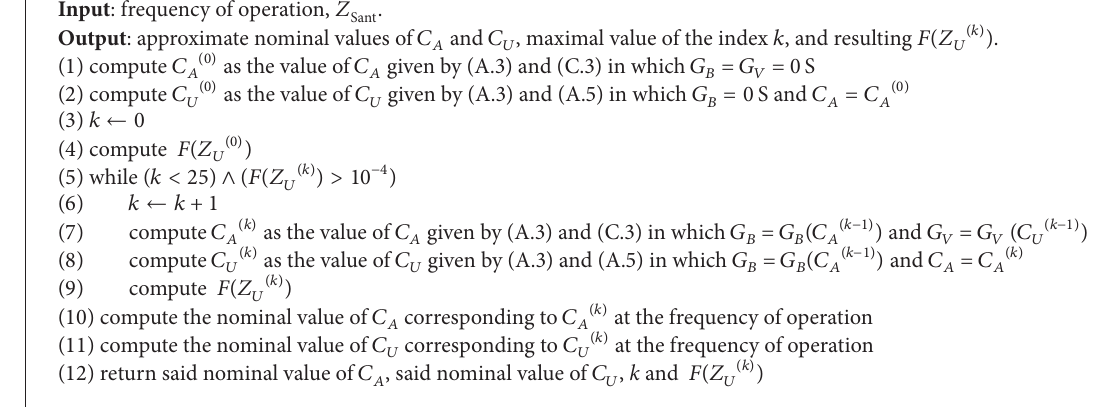
Algorithm 2: Iterative algorithm for computing approximate nominal values of 𝐶 𝐴 and 𝐶 𝑈